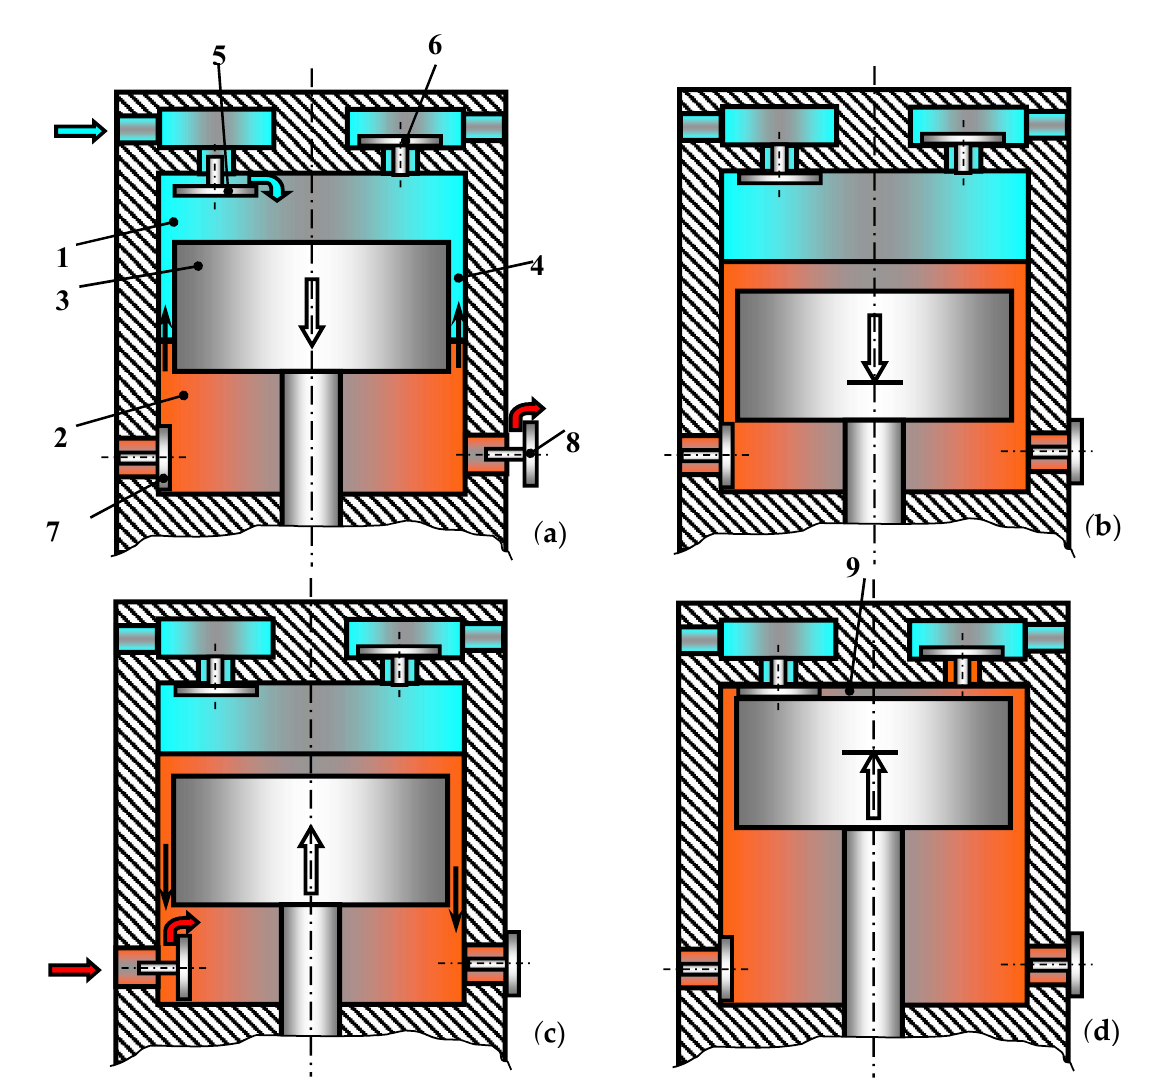
Figure 1. The principle of operation of the piston hybrid power machine (PHPM) with a piston seal made in the form of a smooth gap: ( 1 ) Compressor cavity. ( 2 ) Pump cavity. ( 3 ) Piston. ( 4 ) Smooth gap seal. ( 5,6 ) Suction and discharge valve of the compressor cavity. ( 7,8 ) Suction and discharge valve of the pump cavity. ( 9 ) Dead volume. ( a ) PHPM scheme, movement of the piston from TDC to BDC, with priority movement of fluid from the pump to the compressor; ( b ) PHPM scheme, the piston is in the BDC, the movement of fluid from the pump section to the compressor continues; ( c ) PHPM scheme, the piston moves to TDC, and the fluid from the compressor section moves to the pump cavity; ( d ) PHPM scheme, the piston is at TDC, the fluid moves from the compressor to the